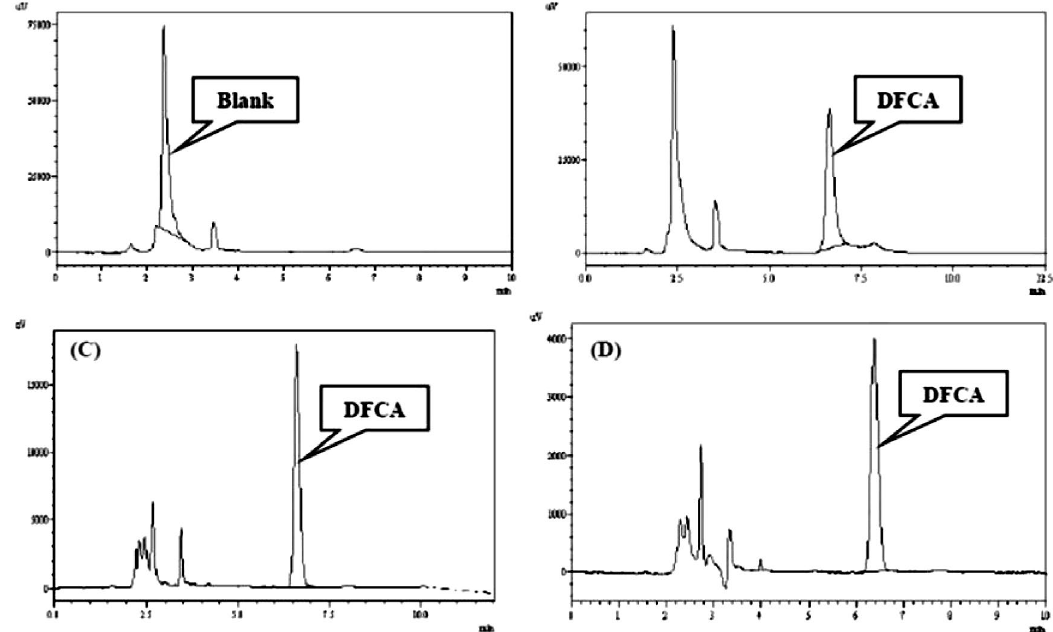
Figure 2 . Representative chromatograms of blank buffalo plasma (A); buffalo plasma spiked with 10 µg/mL of ceftiofur hydrochloride (B); buffalo plasma sample collected at 10 min after intramuscular injection of ceftiofur hydrochloride (C); and buffalo plasma sample obtained at 10 min fol- lowing the subcutaneous administration of ceftiofur hydrochloride (D). DFCA: Desfuroylceftiofur